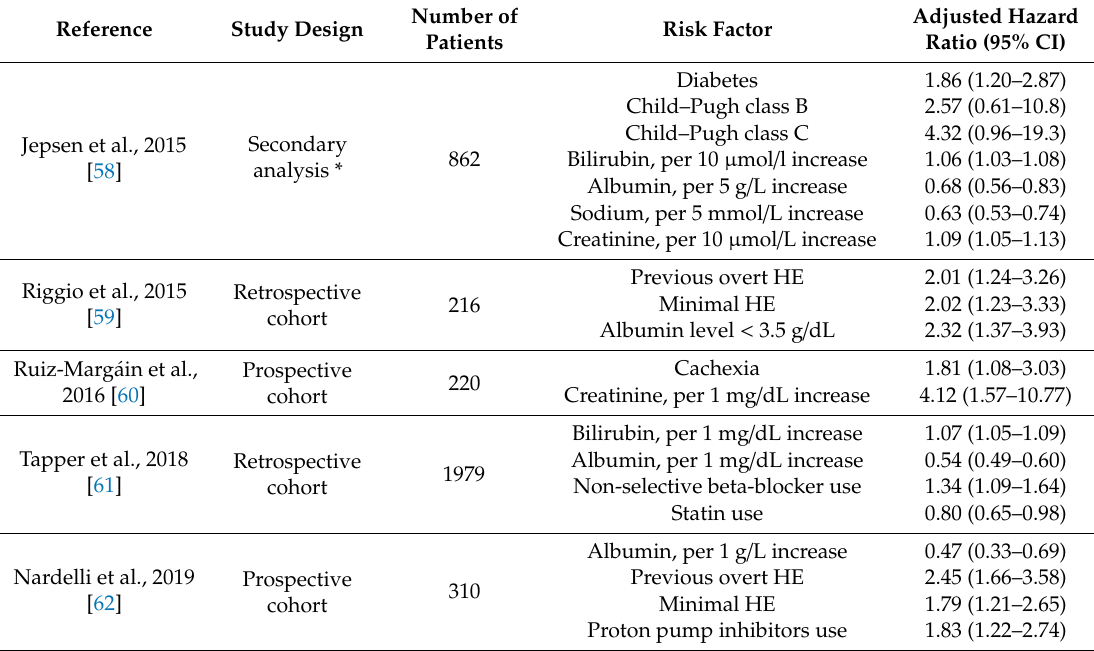
Table 2. Recent relevant publications identifying specific risk factors of overt HE in cirrhosis (adapted from Elsaid et al.